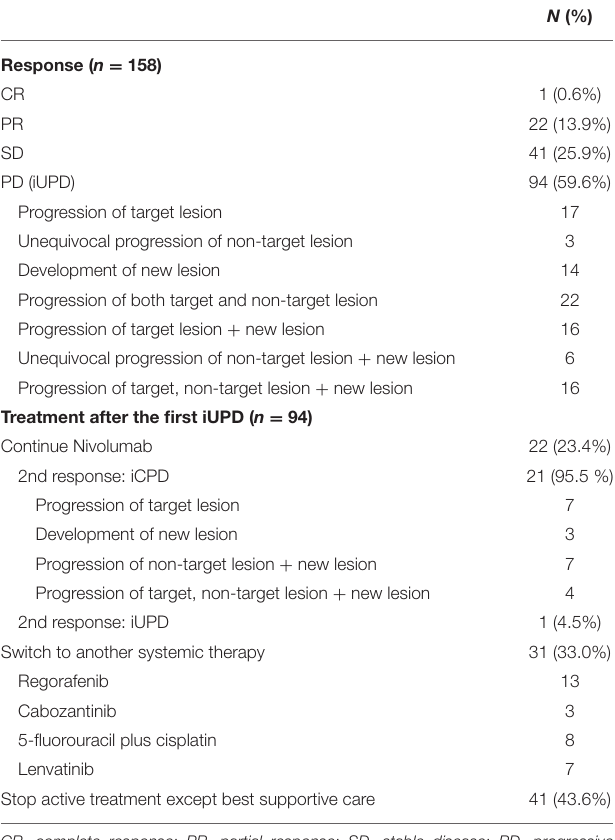
TABLE 1 | Treatment response after immune checkpoint inhibitor with nivolumab for HCC